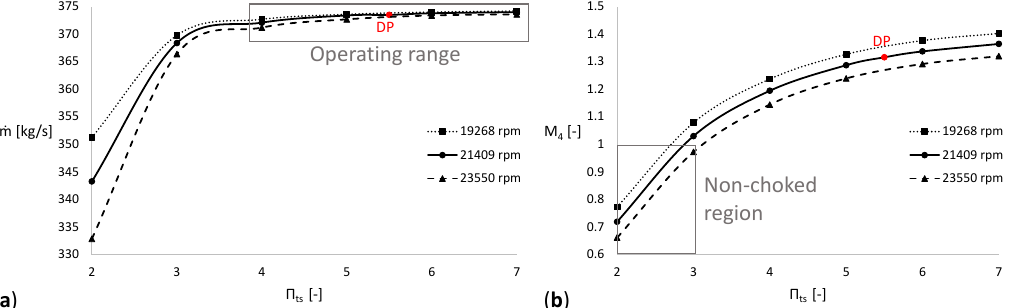
Figure 10. Variation of parameters with total-to-static pressure ratio at three rotational speeds: ( a ) Mass flow, ( b ) Stator outlet Mach